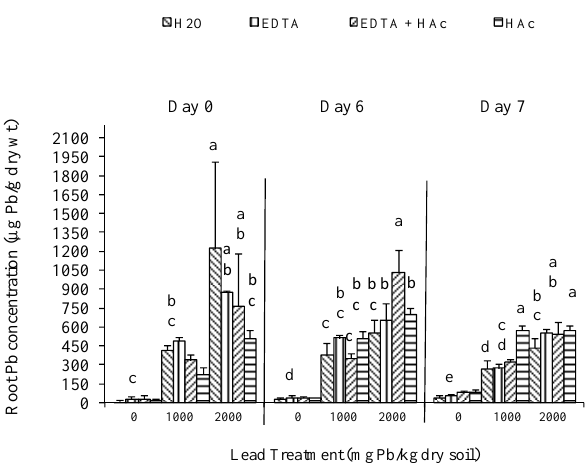
Figure 2: Effects of lead and chelates on root Pb concentrations (µg Pb/g dry wt) of Sesbania exaltata Raf. at different days (0,6, 7) after chelate application. Chelates were applied at 6 weeks after seedling emergence. Values and error bars represent means and standard errors of 4 replicates. Treatments with common letters do not differ significantly from other treatments within the same time period (Fisher's LSD p <